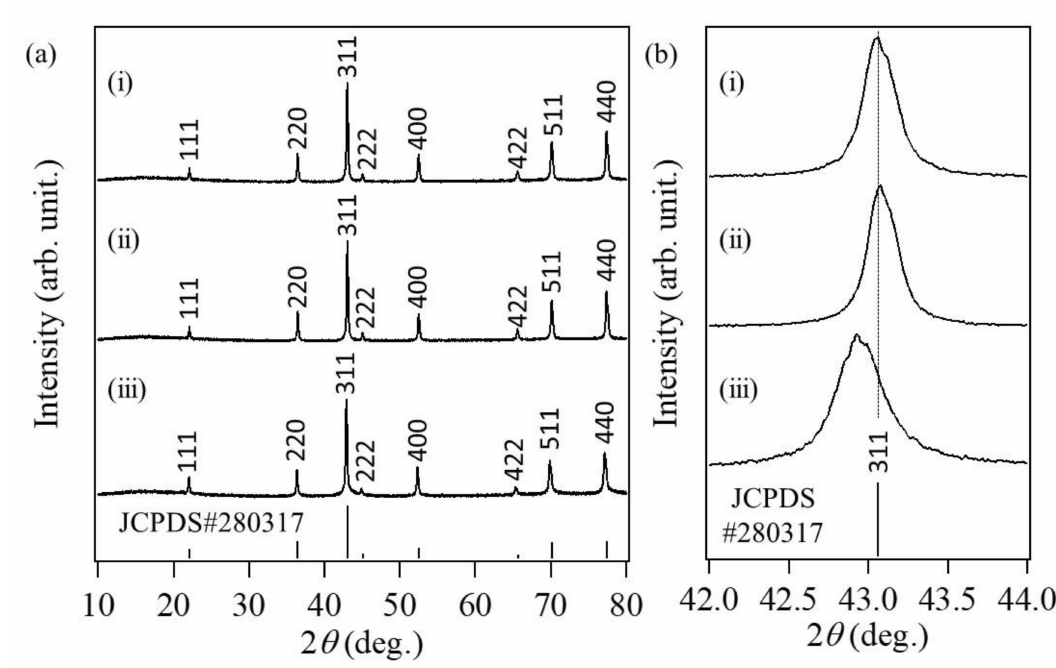
Figure 3. ( a ) Low-angle and ( b ) wide-angle powder X-ray diffraction (XRD) patterns of cobalt oxide